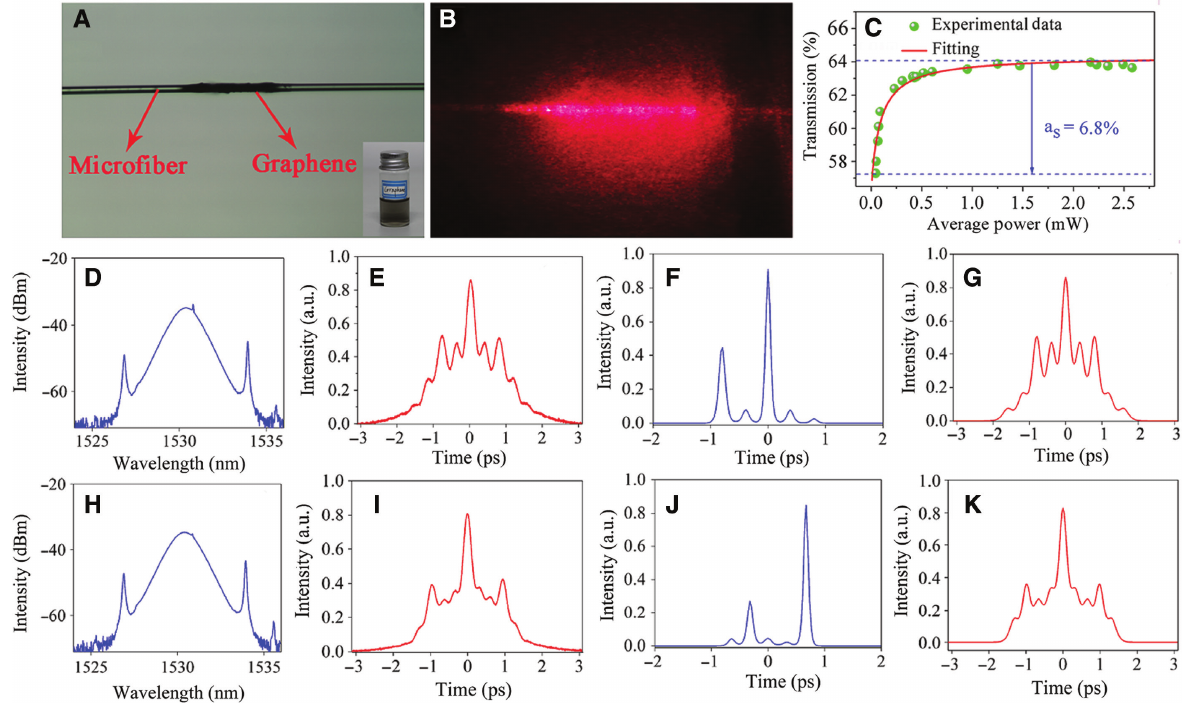
Figure 9: Structural soliton molecules generated in a fiber laser with a microfiber-based graphene SA. (A) Microscopy image of the microfiber-based graphene SA. (B) Scattering evanescent field of the microfiber. (C) Saturable absorption curve and the corresponding fitting curve. (D) and (H) Mode-locked spectra. (E) and (I) Measured autocorrelation traces. (F) and (J) Theoretically plotted pulse profiles. (G) and (K) Recovered autocorrelation traces. Reproduced with permission [177]. Copyright 2014, The Optical